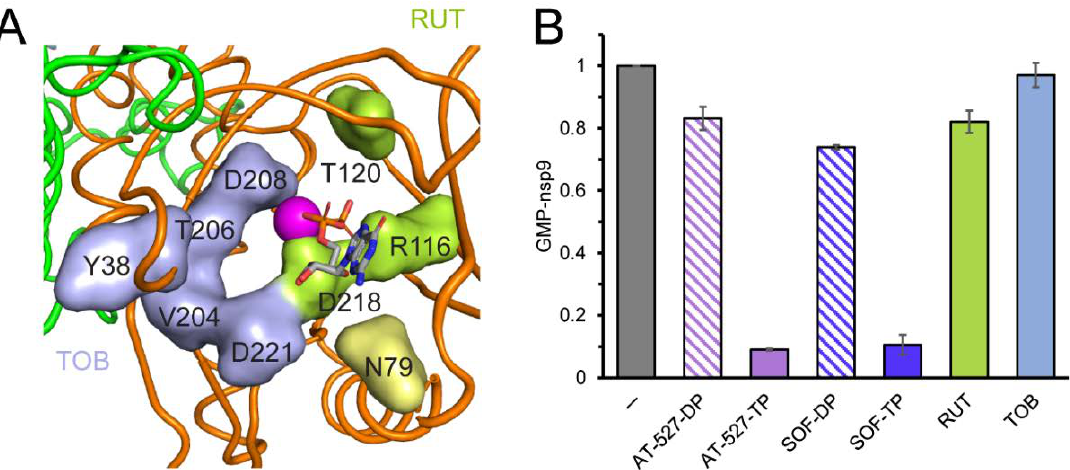
Figure 3. Effects of diphosphates and hypothetical small-molecule inhibitors on NMPylation. ( A ). The NiRAN AS2 (orange) with Mg 2+ ion shown as a magenta sphere and the GDP as sticks. The nsp12 RdRp domain is in green. Residues identified by in silico docking [30] as contact sites for tobramycin (TOB) are shown in slate, those modeled to bind to rutin (RUT)–in green; Asn79 (yellow) could contact both small molecules. ( B ). Diphosphate (DP) forms of AT-527 and sofosbuvir (SOF) are less effective inhibitors of [α 32 P]-GMP transfer to nsp9 than their triphosphate (TP) forms. TOB has no effect on NMPylation, and RUT has a very small negative effect. All molecules were present at 200 μM in a standard assay shown in Figure 2C. NMPylation efficiency was compared to that observed in the absence of competitors (indicated by a grey bar) and is shown as mean ± SD (n = 3).